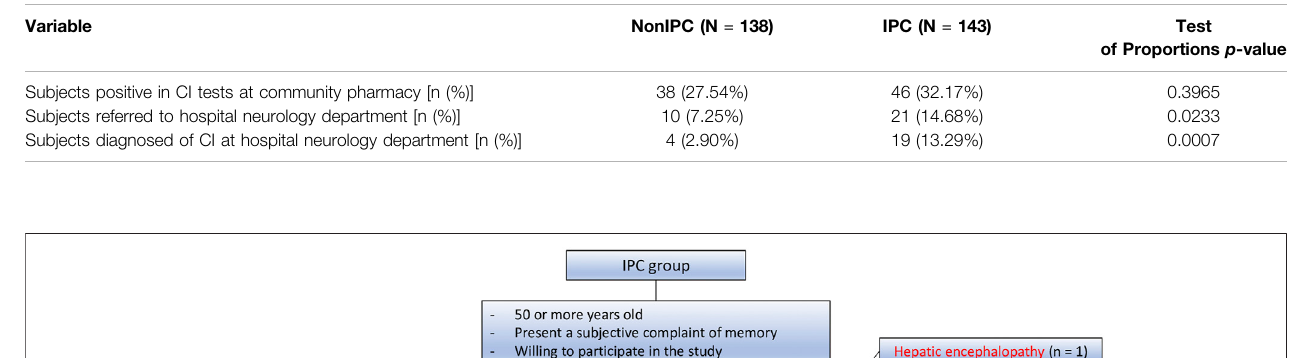
Frontiers in Pharmacology |